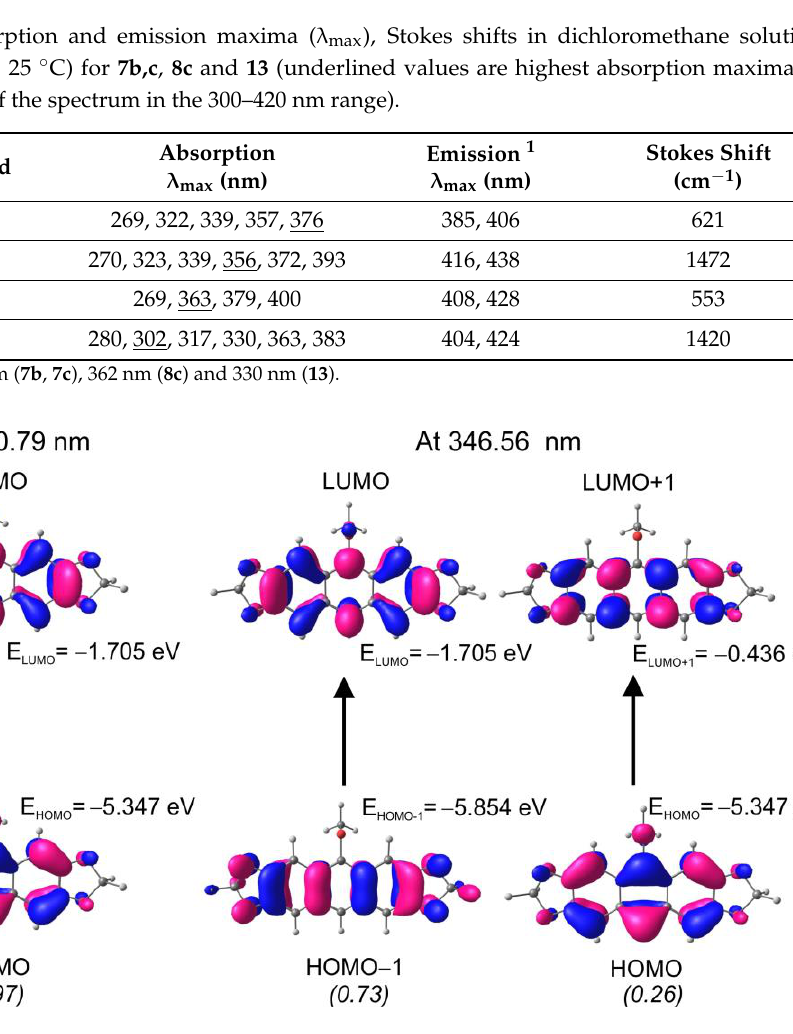
Figure 6. TD-DFT calculated orbitals involved in the electron transitions for 7b